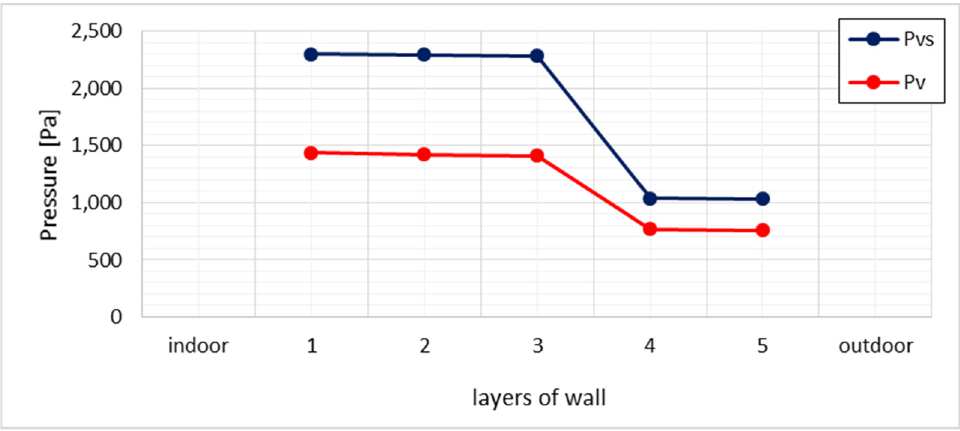
Figure 6. Glaser diagram: trend of saturation and vapour pressures throughout wall 3.